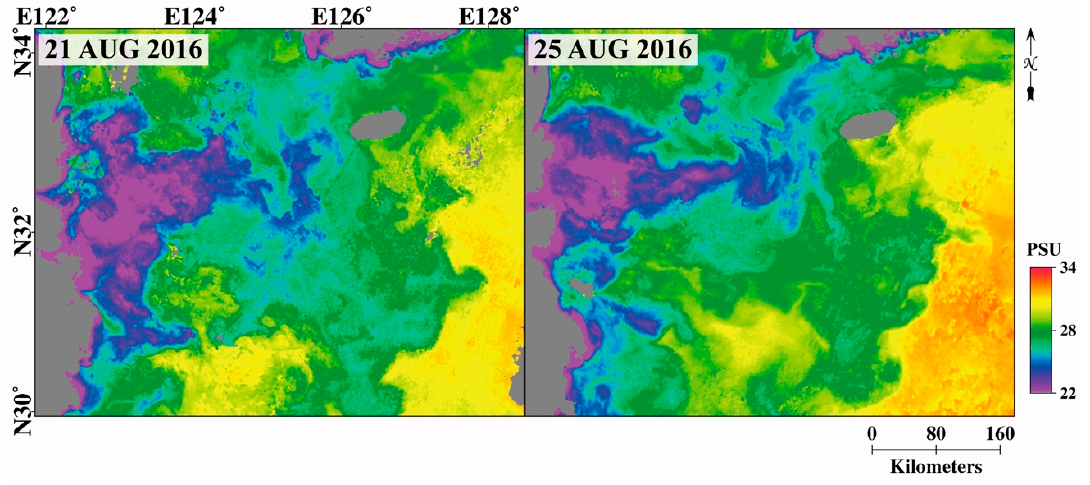
Figure 6. Daily composite SSS images derived from GOCI on 21 and 25 August 2016 in this study.